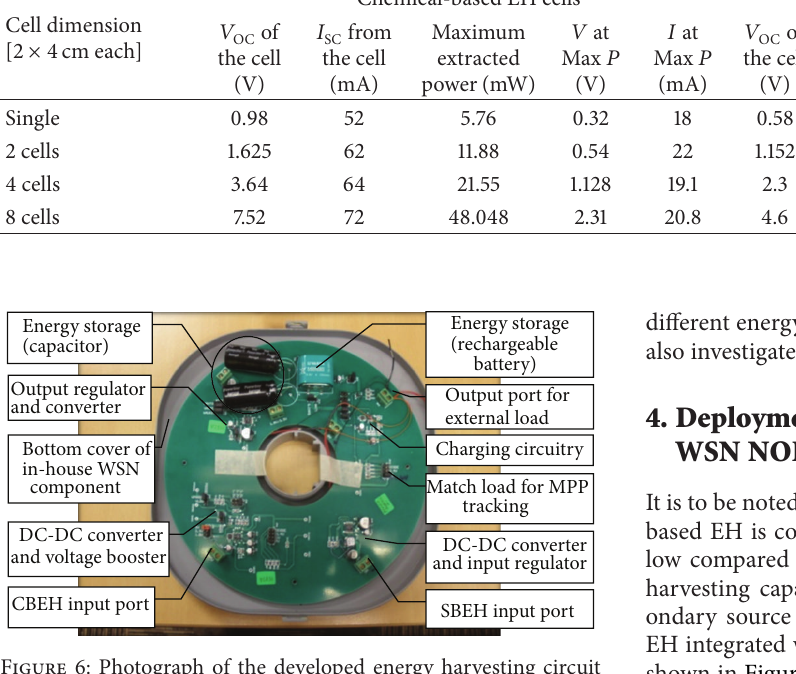
Figure 6: Photograph of the developed energy harvesting circuit with integrated